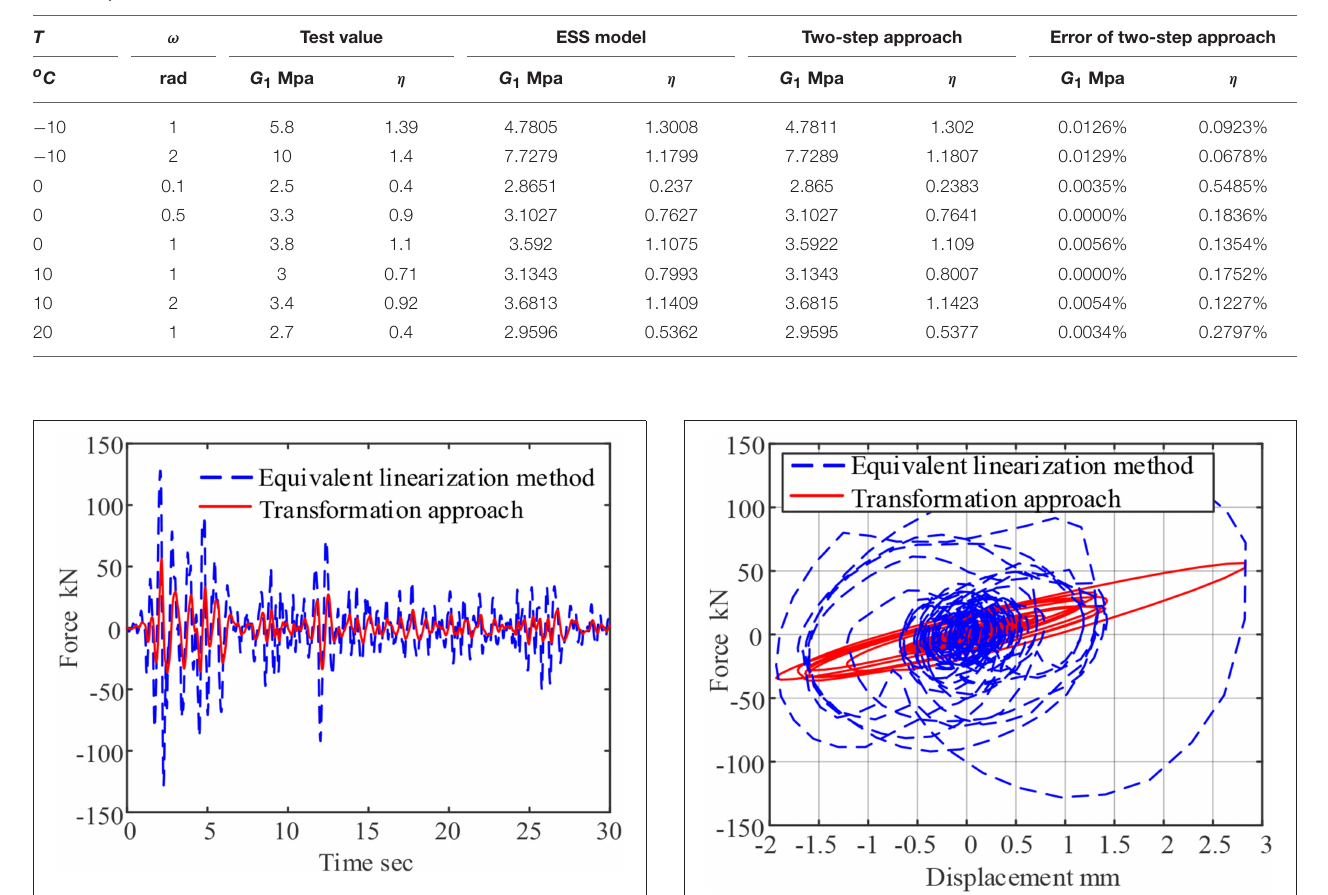
TABLE 1 | Calculation results of 9050A models of viscoelastic materials.